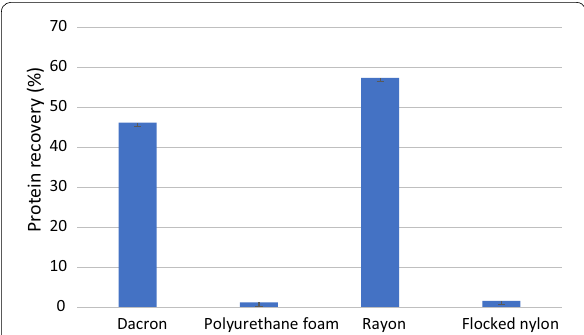
Fig. 5 Diphtheria toxoid recovery from investigated types of